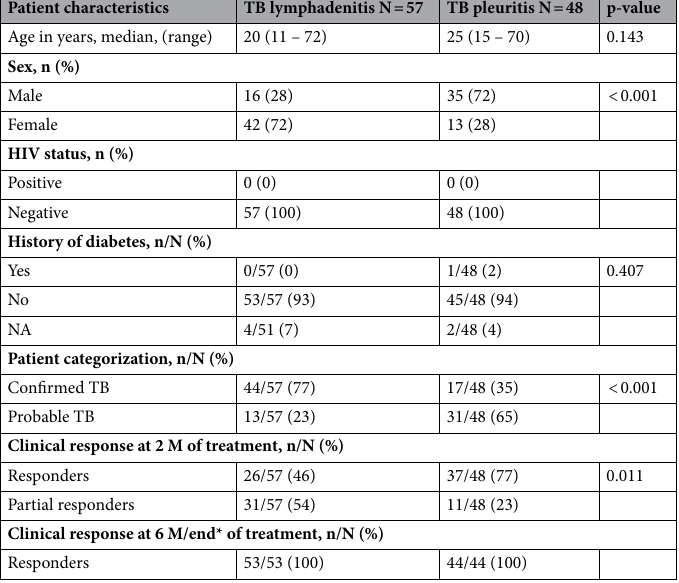
Table 1. Demographic and clinical characteristics of extrapulmonary tuberculosis patients. N total number, n number, %: percentage, NA no information available, TB tuberculosis, M month. *Treatment was extended for 21 patients beyond 6 months. Chi-square test was used to compare groups on categorical data. A p-value < 0.05 was considered